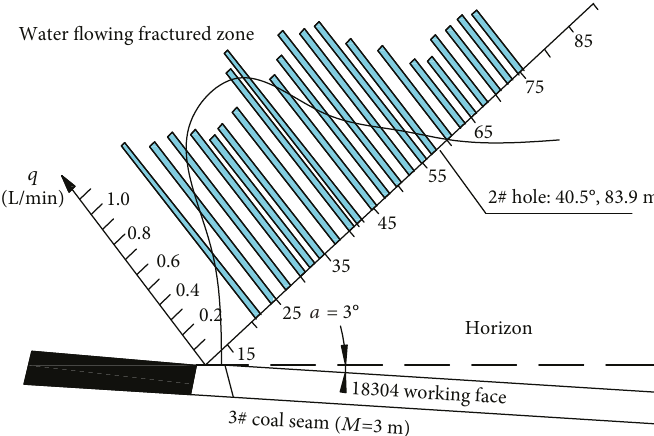
Figure 12: The amount of water leakage of 2# borehole (40.5 ° ) after